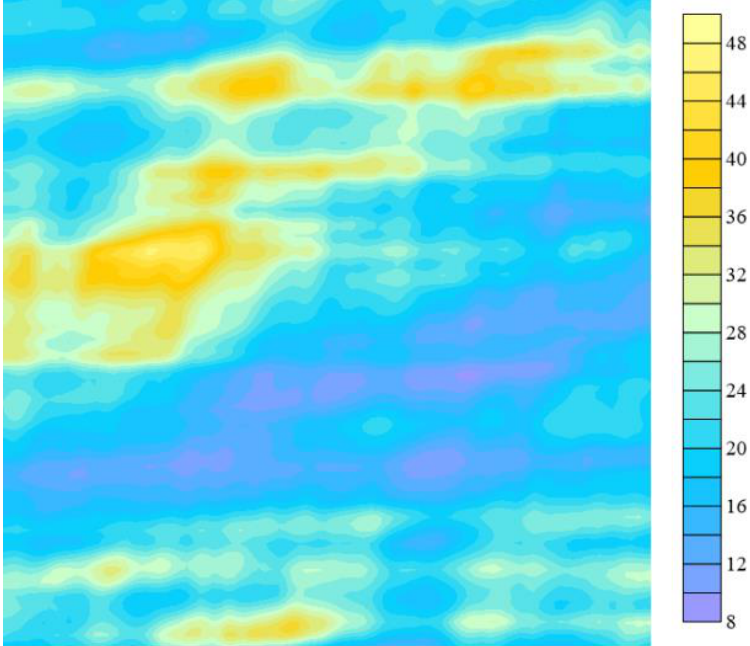
Figure 3. Typical random field realization of soil shear modulus.